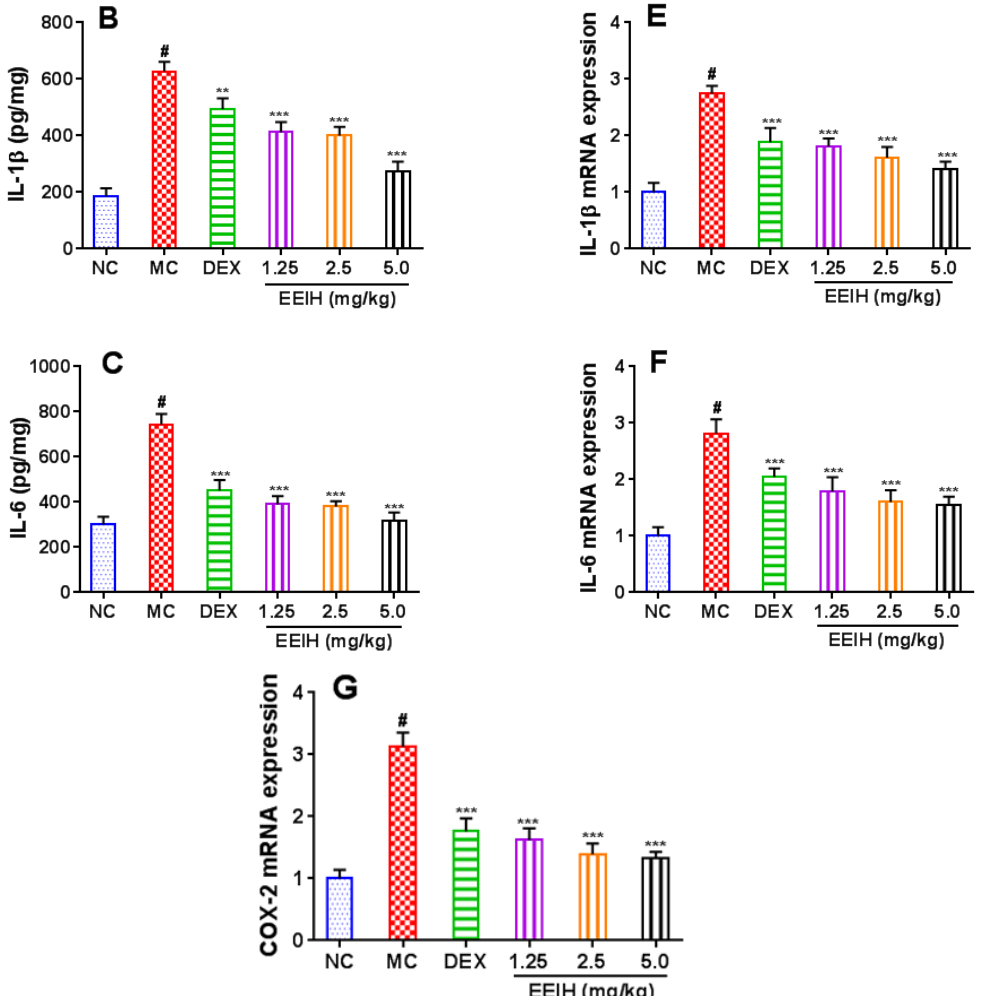
Figure 5. Effects of EEIH on the mRNA and protein expression levels of pro-inflammatory factors in liver tissue of LPS-induced ALI mice. ( A – C ) The levels of TNF-α, IL-1β, and IL-6 in liver tissue were measured using ELISA. ( D – G ) The mRNA expression levels of TNF-α, IL-1β, IL-6, and COX-2 in liver tissue were measured using qRT-PCR. The values are presented as the means ± SD ( n = 5). P values were determined by ANOVA and a Tukey post-hoc test. Significant differences compared to the normal control group (NC) are designated as # p < 0.001, those compared to model control group (MC) as ** p < 0.01, and *** p < 0.001.